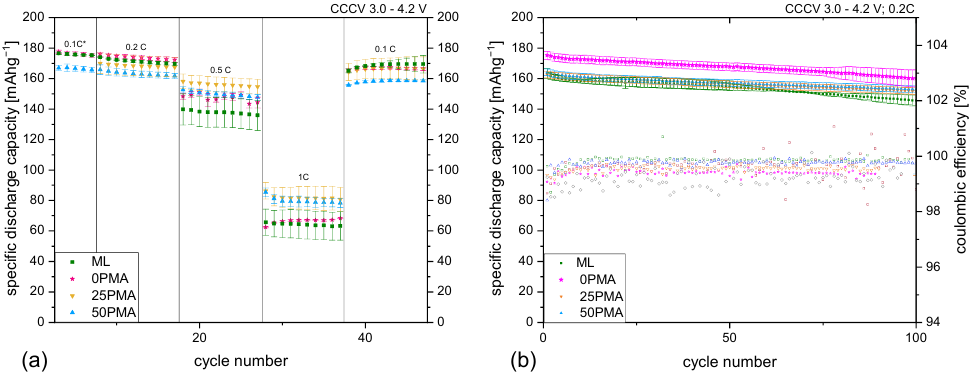
Figure A5. ( a ) Rate capability test including ML samples from a previous study [8], ( b ) results of 100 cycles at 0.2C including coulombic efficiencies and statistical errors.